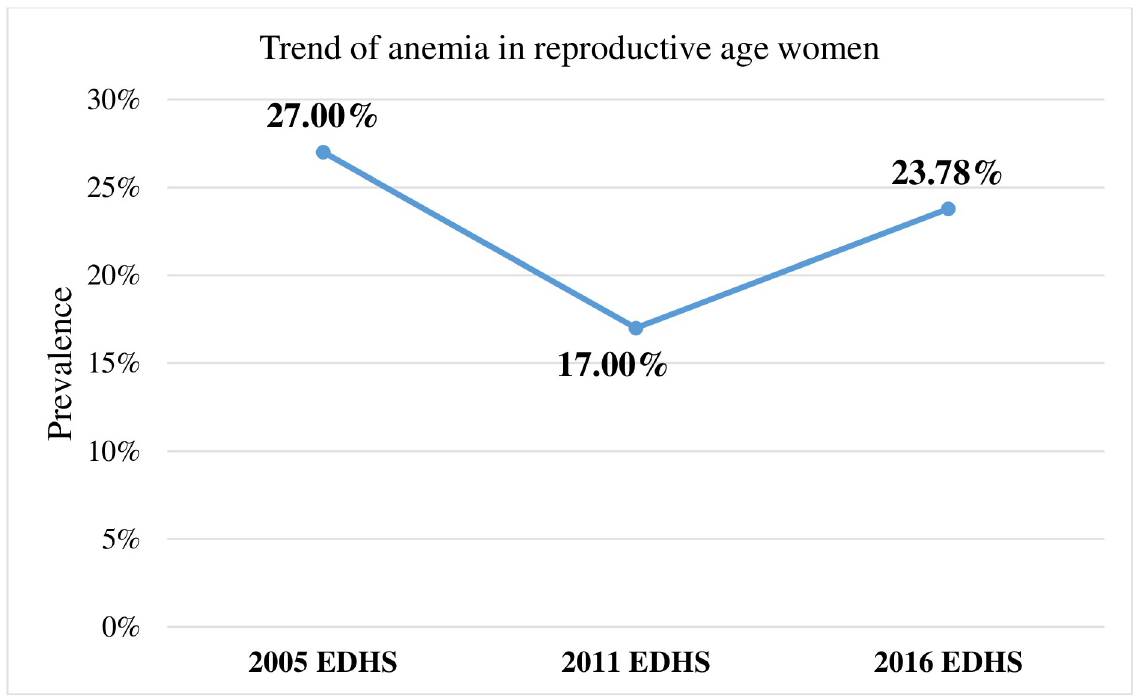
Fig 2. The line graph on the trend of anemia in reproductive age women from